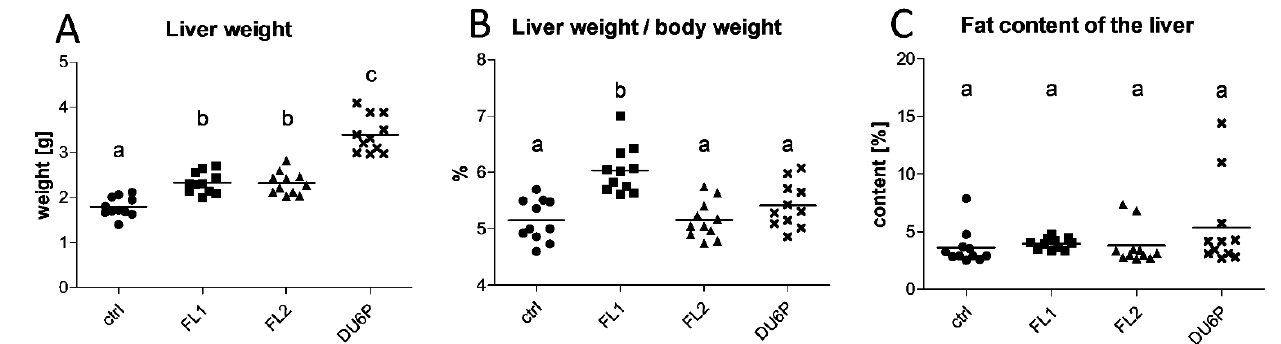
Figure 3. Liver weight ( A ) and liver weight ratio with respect to body weight ( B ) in control (circles), FL1 (squares), FL2 (triangles) and DU6P (crosses) lines. Content of fat in the liver in the same lines ( C ). Data are illustrated as the mean ± SEM (standard error of the mean) and designated significant if p < 0.05 (Tukey posttest: different letters correspond to different levels of significance). We also analyzed the fat content in plasma samples and found that only in the FL1 line the lipid portion was lower than that in the control (Figure 4).